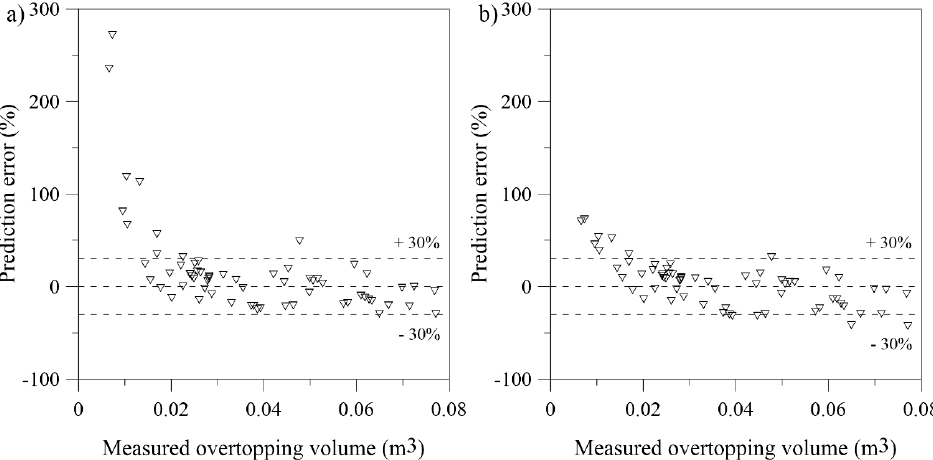
Figure 14 : Prediction error for the measured overtopping volume: ( a ) predicted with Equation (4); ( b ) predicted with Equation (6). J. Mar. Sci. Eng. 2018 , 6 , x FOR PEER REVIEW